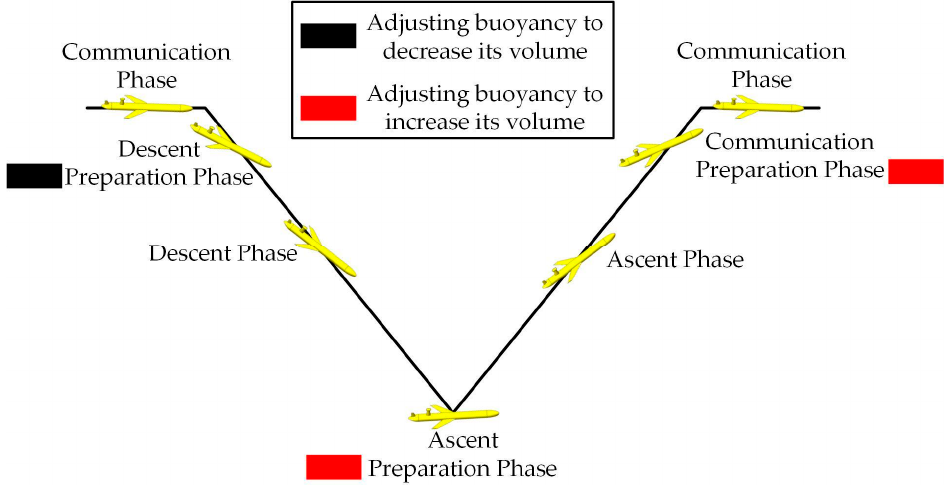
Figure 8. Introduction of the various working phases of the glider in the normal gliding mode.